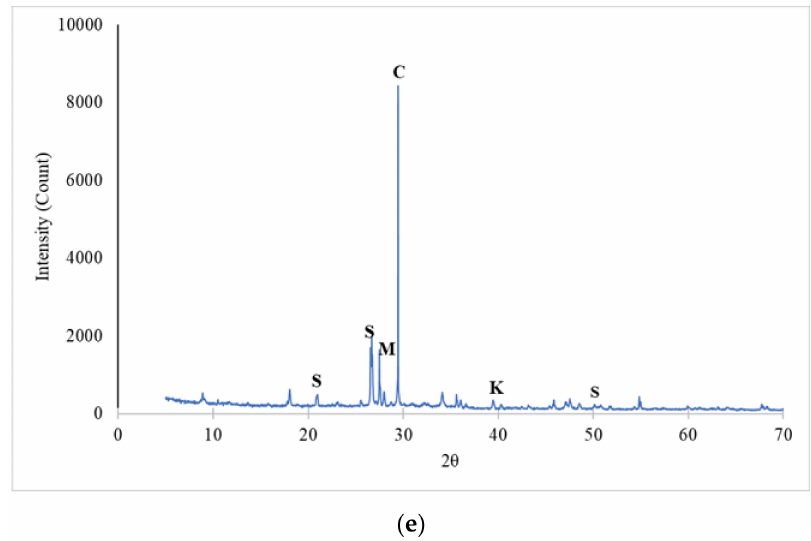
Figure 17. XRD Pattern of concrete mix containing CCR and NS. ( a ) M0C0N. ( b ) M0C3N. ( c ) M7.5C3N. ( d ) M15C2N. ( e )